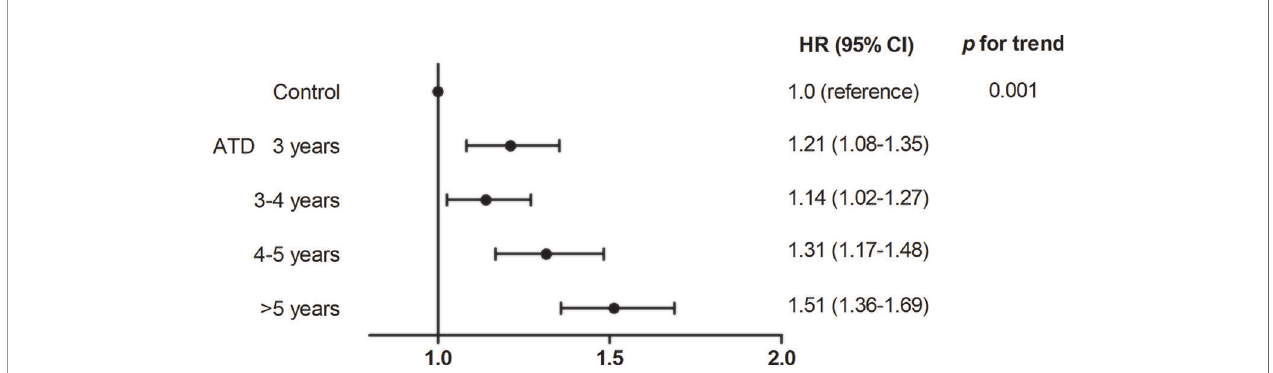
FIGURE 3 | Association between duration of anti-thyroid drug use and risk for heart failure. ATD, anti-thyroid drug; HR, hazard ratio; CI, con fi dence interval.